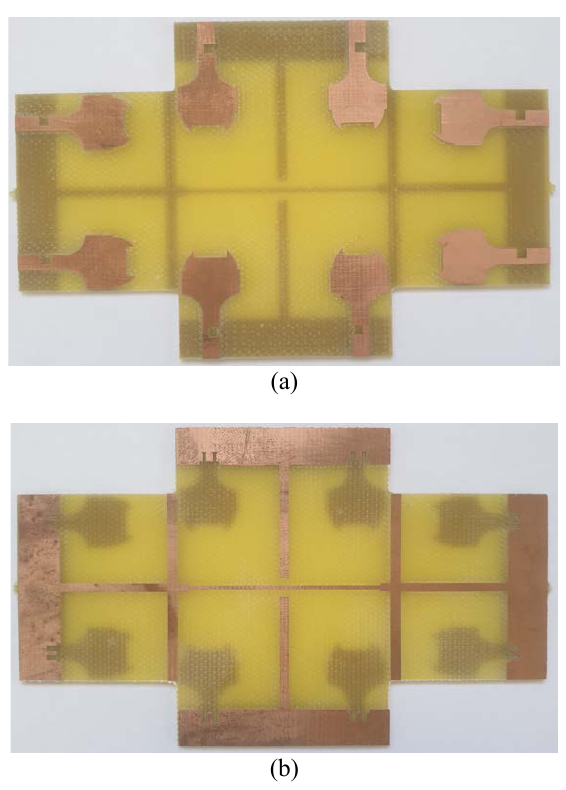
FIGURE. 10 Photographs of the presented MIMO antenna, (a) top view, (b) bottom